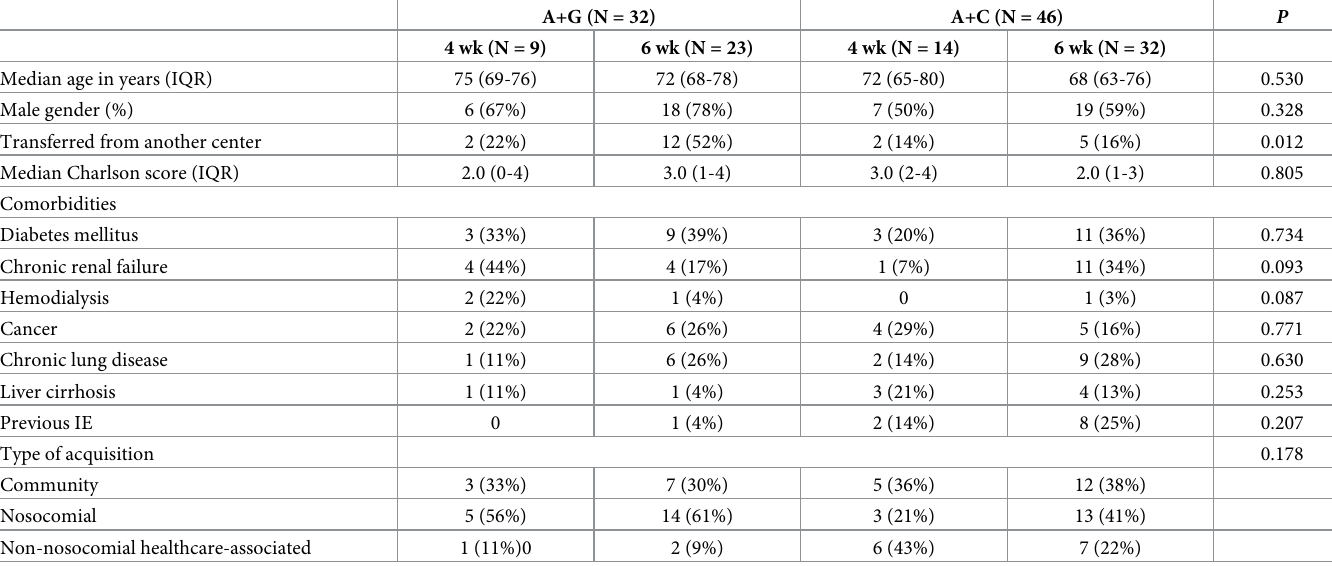
Table 1. Demographic and baseline clinical characteristics of 78 patients with